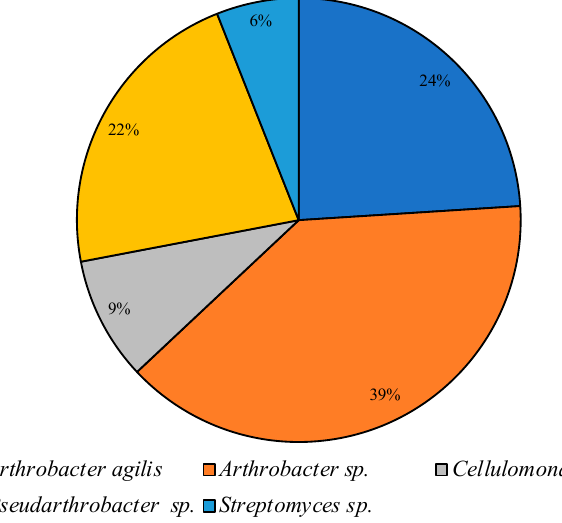
Figure 5. Structure of the culturable bacterial community isolated on PYG medium at 10 °C.